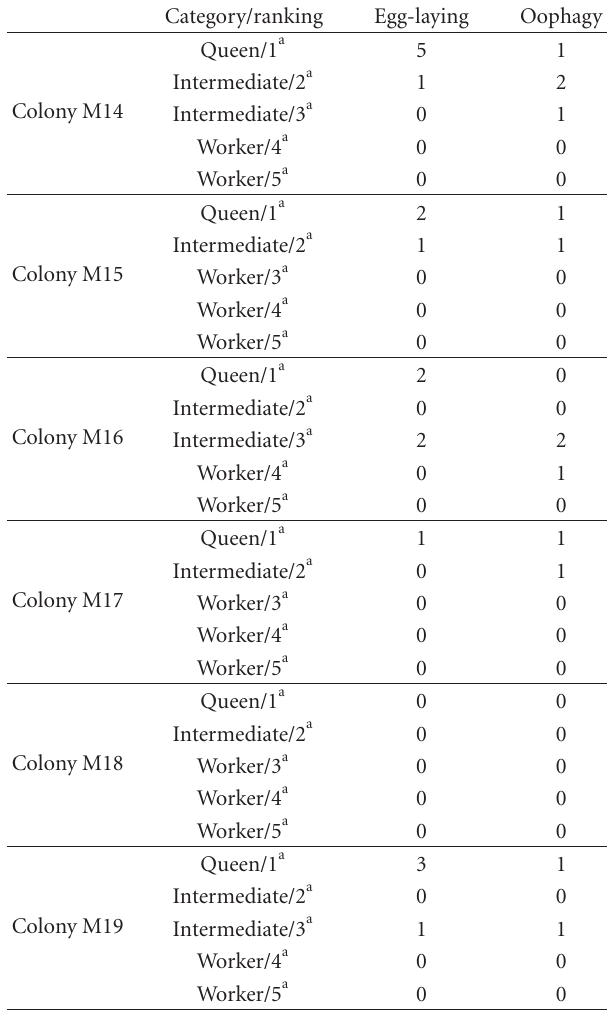
Table 5: Female category, ranking position, absolute frequency of egg-laying, and oophagy behaviors observed for each colony during the observation.